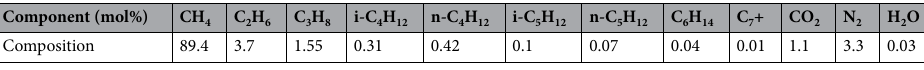
Table 1. The natural gas composition in mole